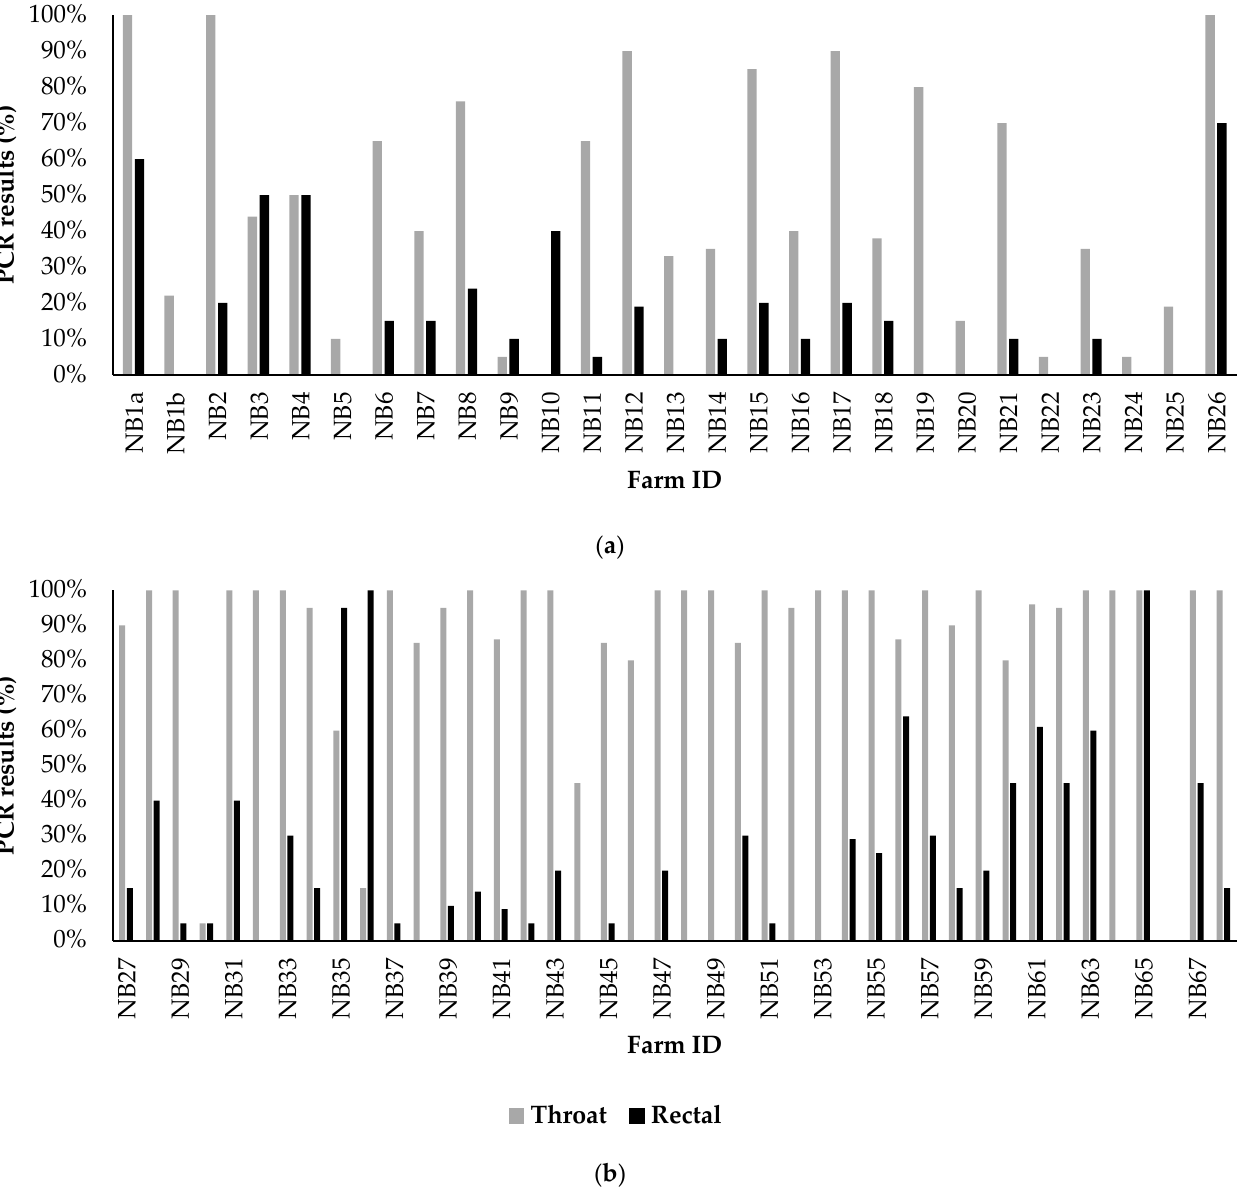
Figure 3. Percentage of SARS-CoV-2 positive rectal or throats swabs taken at official sampling by the competent authority. Twenty rectal and 20 throat swabs were taken from minks with clinical signs or from mink in cages with prior observed mortality if present, and otherwise randomly. ( a ) NB1a-NB26, diagnosed between 31 May and 1 August; ( b ) NB27-NB68 diagnosed between 1 August Similar to the increase in clinical signs during the course of the epidemic, the percent- age of positively tested throat swabs also increased (Figure 3, Tables S2 and S4). Throat swabs tested more positive, often close to 100%, for farms diagnosed from August onwards compared to farms diagnosed before August (Chi-square, X-Squared = 24.6, p < 0.05). No significant differences were found in the number of signs between the different categories of PCR test outcomes (<25%, 26–74%, and >75% positive). Furthermore, no significant differences in PCR test results of the throat and rectal swabs were found for the different virus clusters.